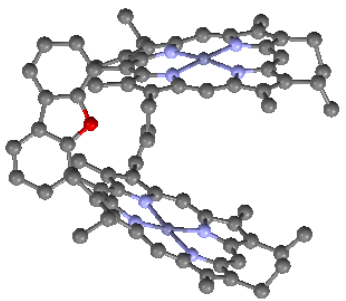
Figure 20. Dibenzofuran-bridged cofacial bisporphyrin, from data in [7,56]. Dark blue = Zn, red = O.